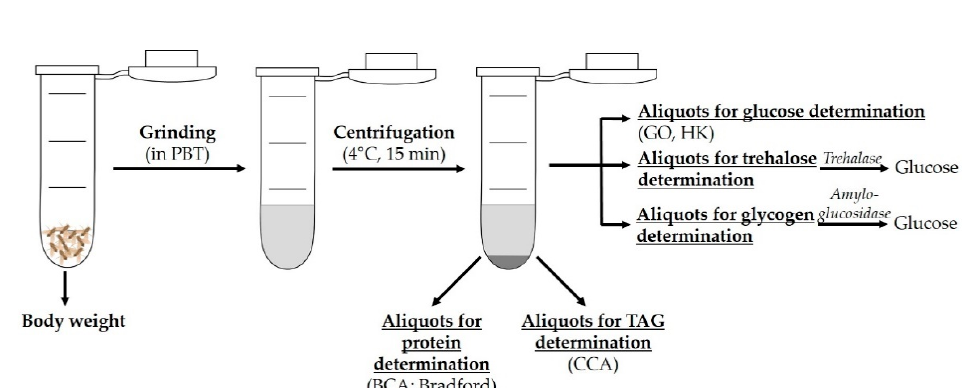
Figure 1. Exemplary protocol for assessment of the body composition of Drosophila melanogaster . After determining their body weight, flies are ground in Dulbecco’s phosphate-buffered saline with Triton X-100 (PBT) by using a tissue homogenizer. Following centrifugation, aliquots of the supernatant are utilized for further measurements. The protein content is determined with a bicinchoninic acid (BCA) or Bradford assay, the TAG content with coupled colorimetric assays (CCAs) and the glucose content with enzymatic methods based on the enzyme glucose oxidase (GO) or hexokinase (HK). For assessment of trehalose and glycogen concentrations, enzymatic treatments with trehalase and amyloglucosidase are conducted, respectively, after which free glucose is determined (modified from [28]).